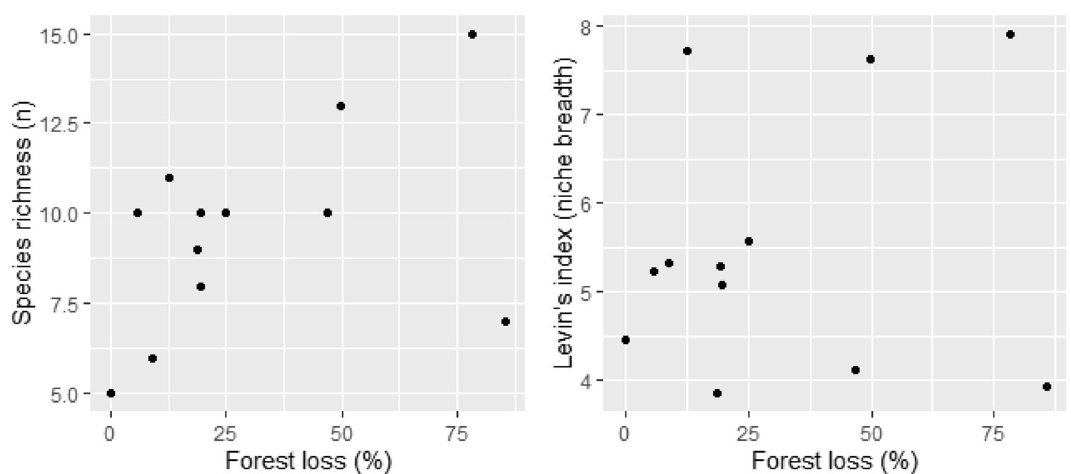
Figure 6. Effects of forest loss (3-km buffer) on the predation ecology of harpy eagles. Eagles nesting in highly deforested landscapes exhibited levels of prey diversity and dietary niche breadth that were similar to those in more relatively intact landscapes, with sloths and primates as the main